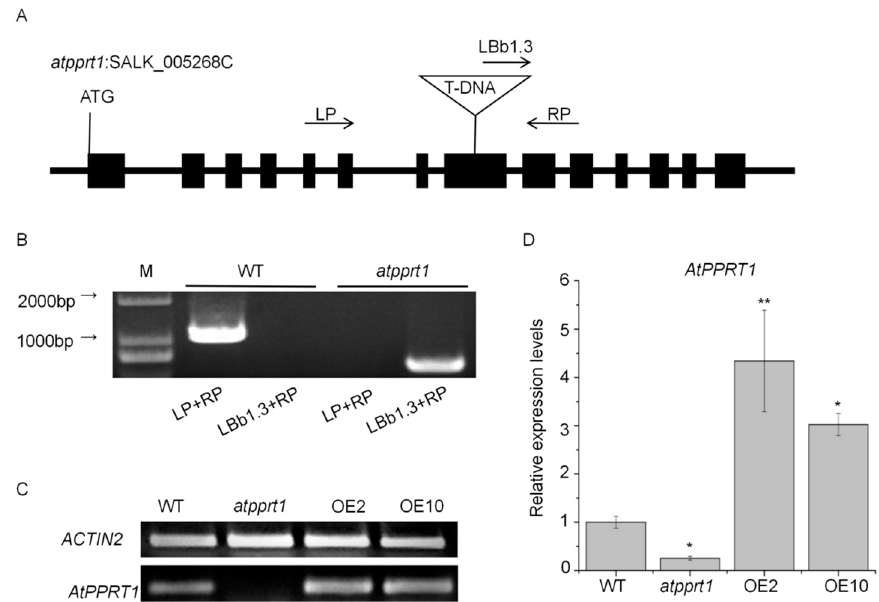
Figure 2. Identification of atpprt1 mutant and AtPPRT1 -overexpressing lines. ( A ) The structure of the AtPPRT1 gene and T-DNA insertion site in the atpprt1 mutant (SALK_005268C); ( B ) Molecular analysis of wild-type (WT) and the atpprt1 mutant. The primers (LP, RP, and LBb1.3) were used in the experiment. M represents the molecular marker; ( C ) Semi-quantitative RT-PCR analysis of AtPPRT1 expression levels in WT, atpprt1 , and AtPPRT1 -overexpressing lines OE2 and OE10; ( D ) qRT-PCR analysis of AtPPRT1 expression levels in WT, atpprt1 , and OE2 and OE10. ACTIN2 was used as the internal control for both semi-quantitative RT-PCR and qRT-PCR. The values are the average of three individual biological replications. Error bars represent ± SD ( n = 3, * p < 0.05 and ** p < 0.01, t -test). 2.3. The Expression of AtPPRT1 is Induced by ABA and is Increased in the Root Tips of Seedlings